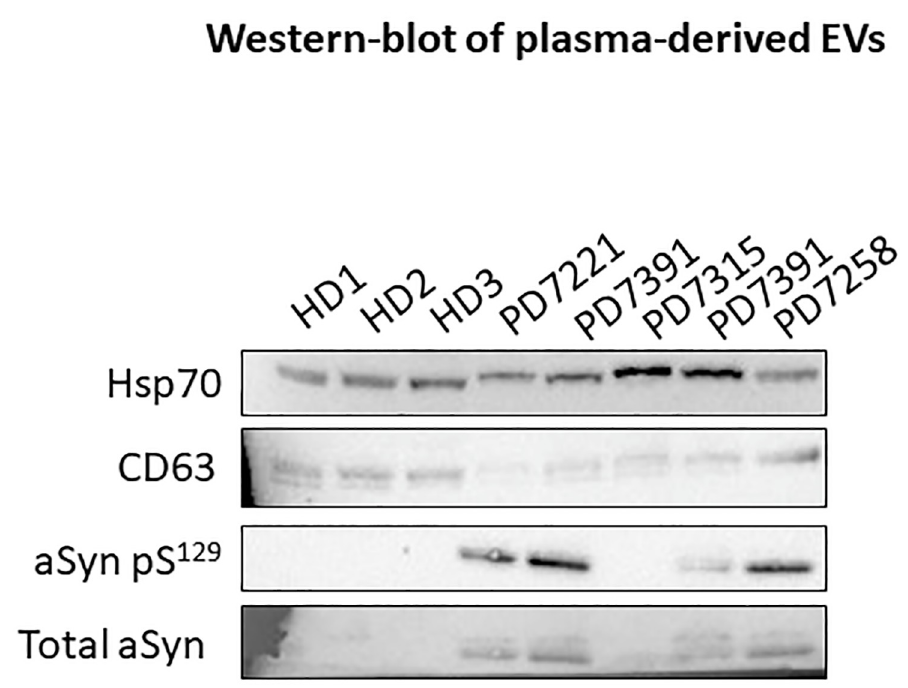
Fig 2. Western blot of plasma-derived EVs comparing healthy donors and PD patients. Total aSyn and aSyn S129 are detectable only on PD samples. No difference has been detected between total aSyn and aSyn